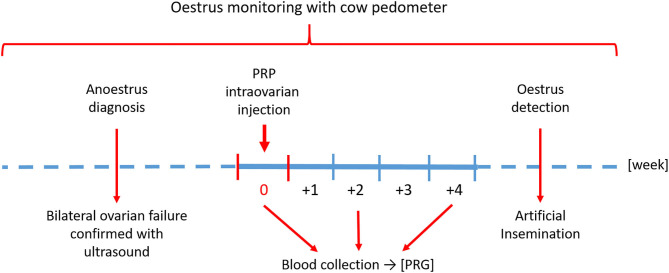
Timeline of the study.